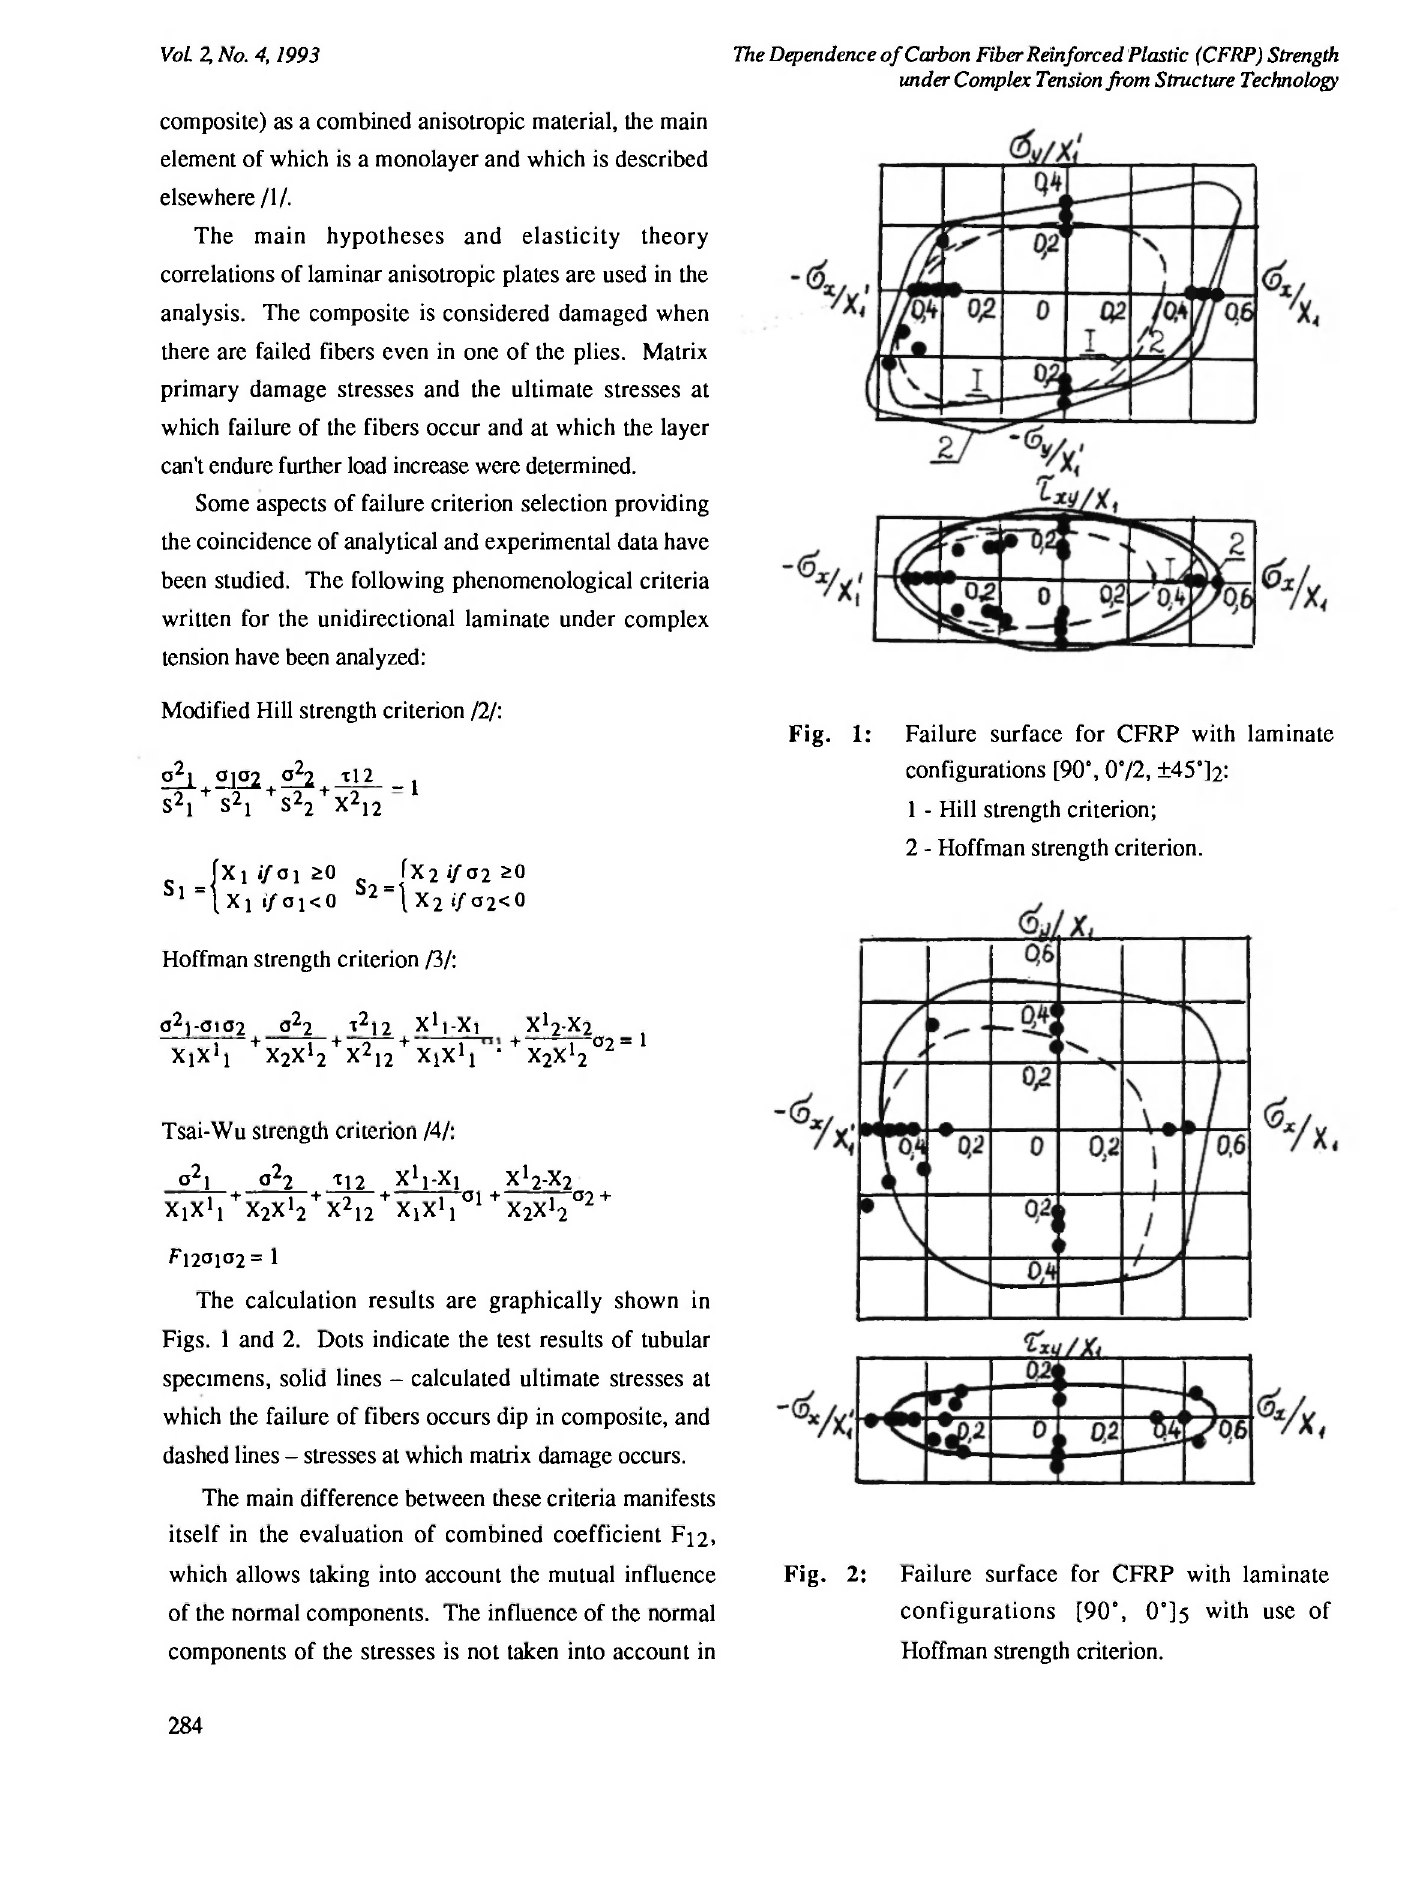
Fig. 1: Failure surface for CFRP with laminate configurations [90°, 0°/2, ±4512: 1 - Hill strength criterion; 2 - Hoffman strength criterion.